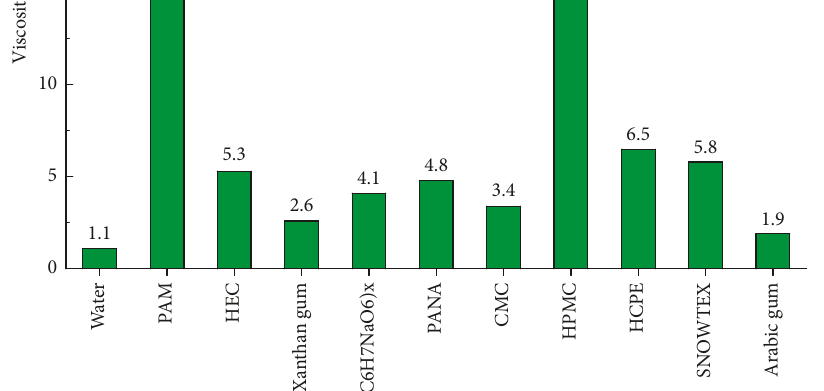
Figure 4: Viscosities of the different cellulose.